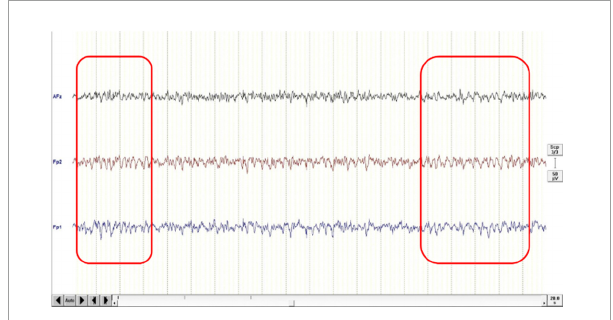
FIGURE3 An example of Fm θ lasting more than 1 s during a simple calculation